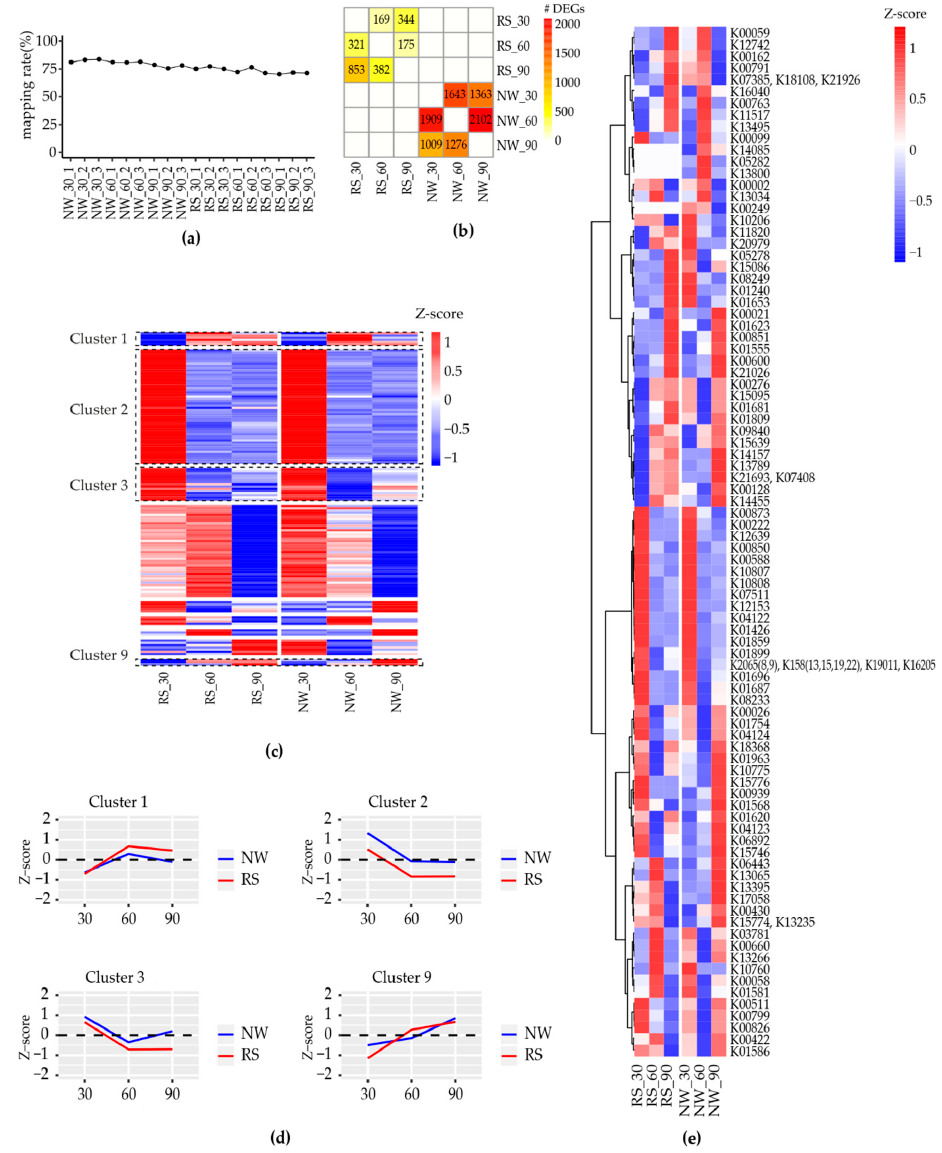
Figure 2. Overview of the differential expression patterns obtained from the given conditions: ( a ) individual sequence library reads mapped to the representative transcriptome; ( b ) quantitative summary of the differentially expressed transcripts concerning plant developmental stages; ( c ) a total of 137 differential expressed transcripts from all given pairs of conditions and their selected K ‐ means hierarchical clusters, upon the desired expression patterns; ( d ) selected clusters from 137 common differentially expressed transcripts; and, ( e ) secondary metabolite transcripts which are involved in differential expression. Here, the transcripts were grouped into KEGG ortholog IDs, and the average expressions are shown while multiple transcripts belong to same ortholog ID. NW: Papaver nudicaule , RS: Papaver rhoeas .